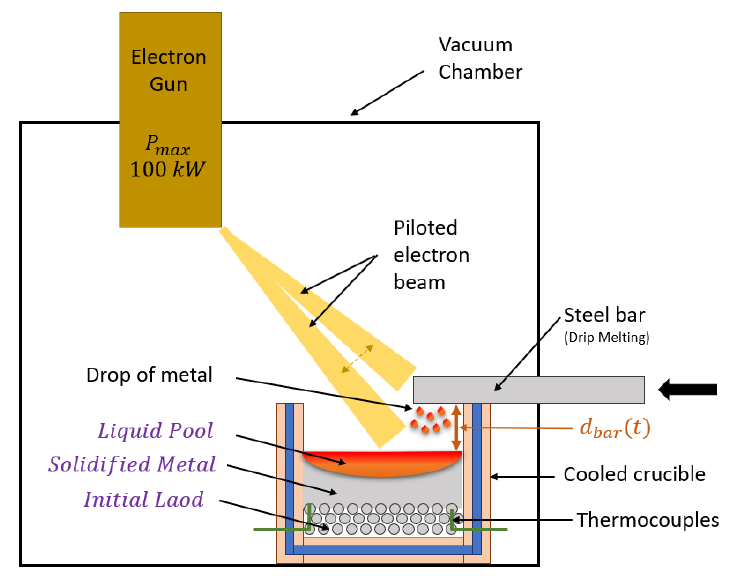
Figure 2. Schematics of the experimental set-up.